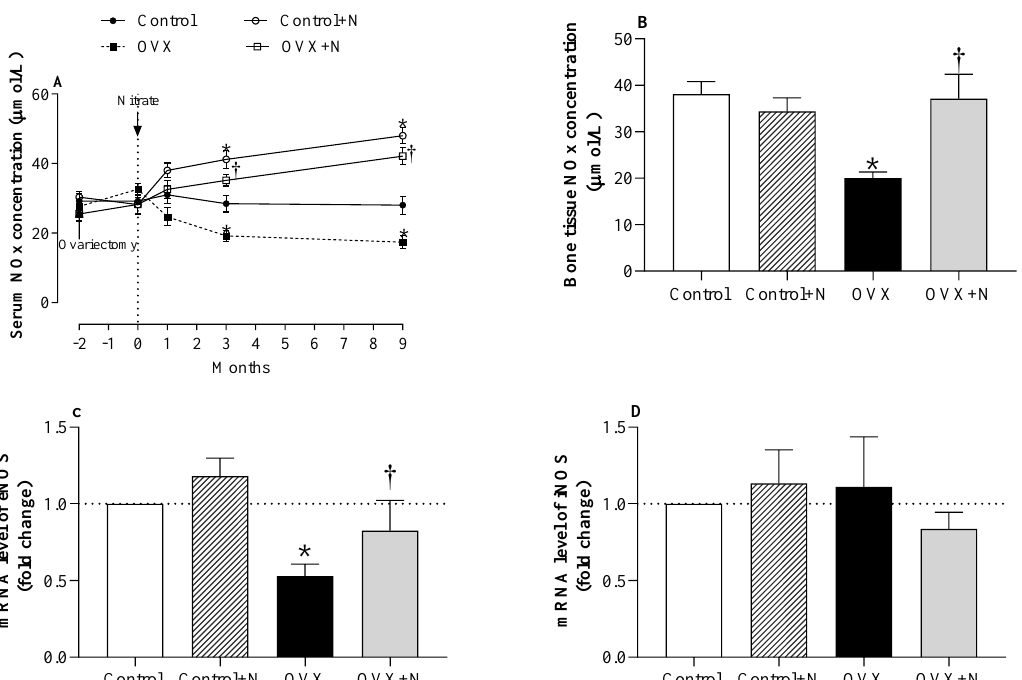
Figure 2: Effect of inorganic nitrate on ( A ) serum nitric oxide (NO) metabolites (NOx) during the study, ( B ) bone NOx levels, ( C ) bone mRNA expression of the endothelial NO synthesis (eNOS), and ( D ) inducible NOS (iNOS) at month 9 in ovariectomized (OVX) and control rats. *,† P < 0.05 compared to control and OVX rats, respectively. Results are mean ± SEM